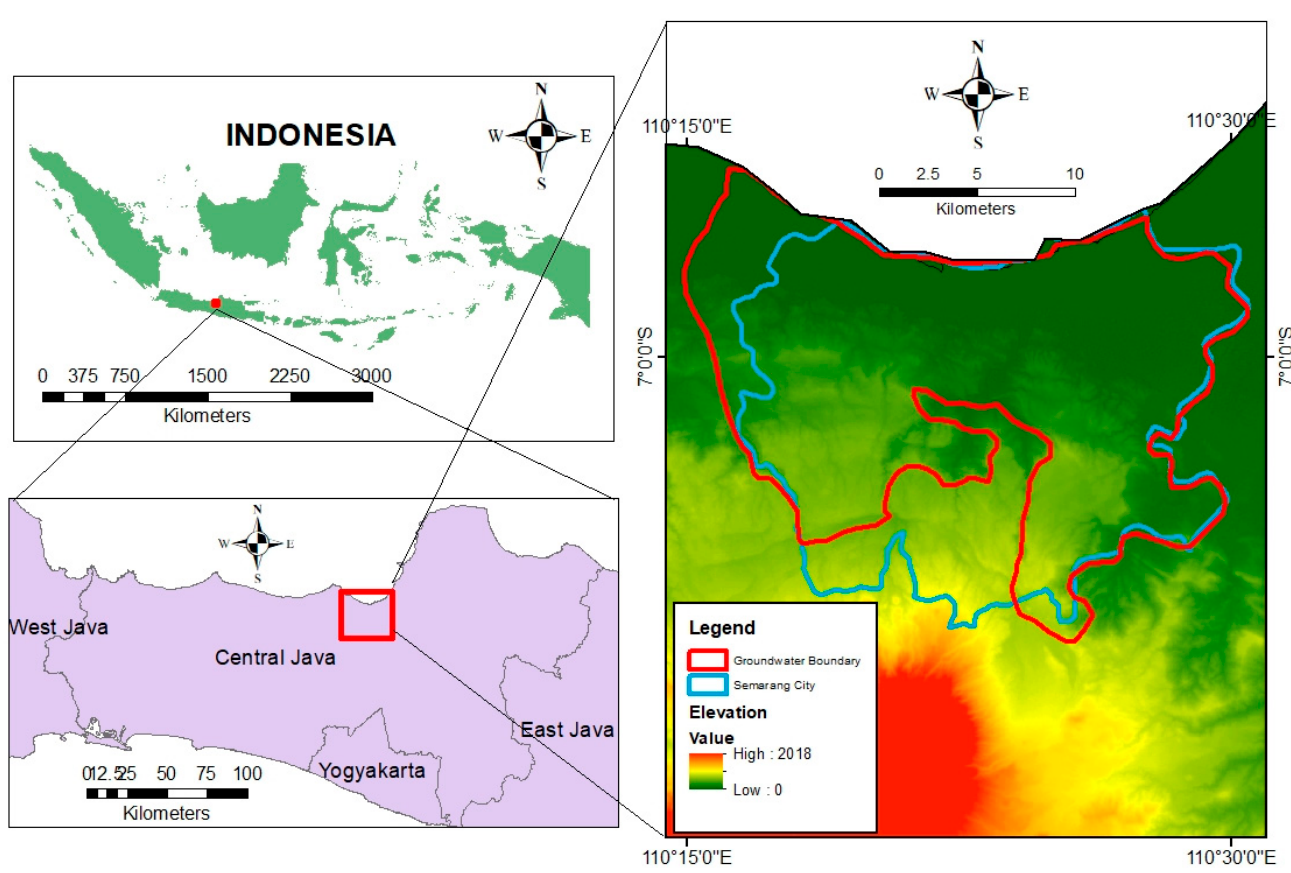
Figure 1. Study area—Semarang City.